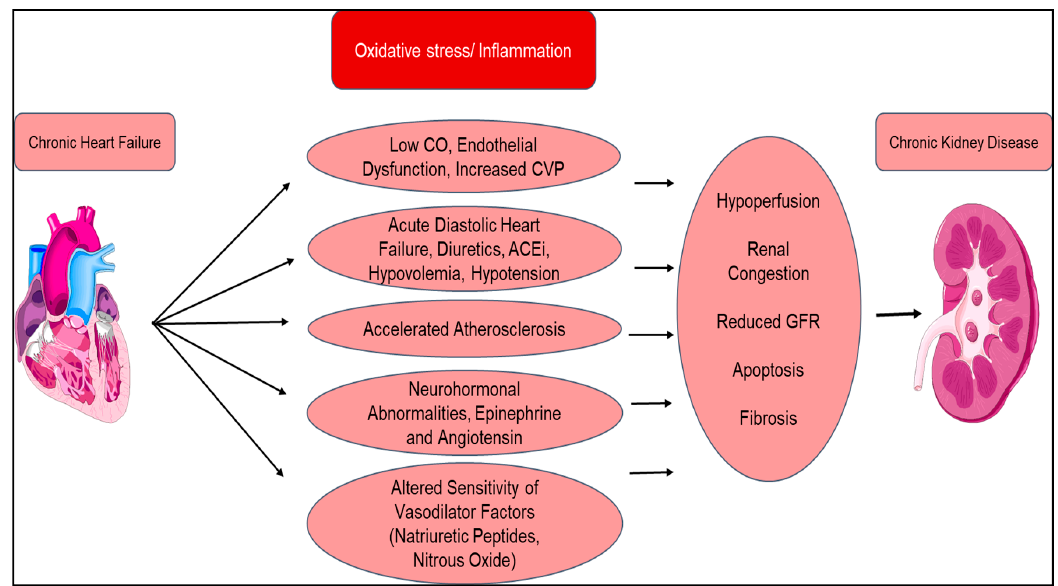
Figure 3. Pathophysiology of chronic cardiorenal syndrome (type 2): mechanism of how multiple effects of chronic heart failure lead to progressive and chronic kidney disease (CKD) because of neurohormonal upregulation, leading to altered vasoconstriction and vasodilation. CO = cardiac output; CVP = central venous pressure; ACEi = angiotensin-converting enzyme inhibitor.